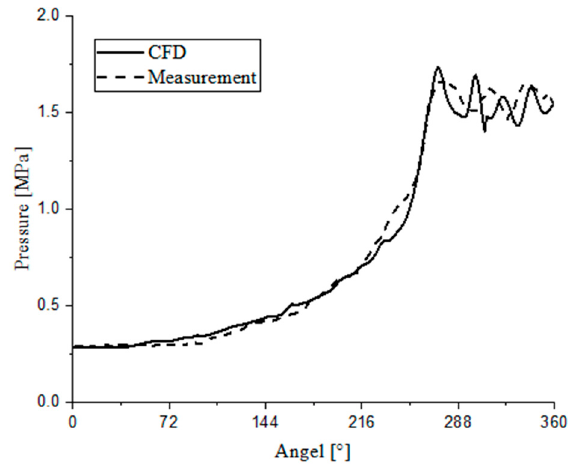
Figure 14. The P- θ diagram of the screw refrigeration compressor under full load conditions.